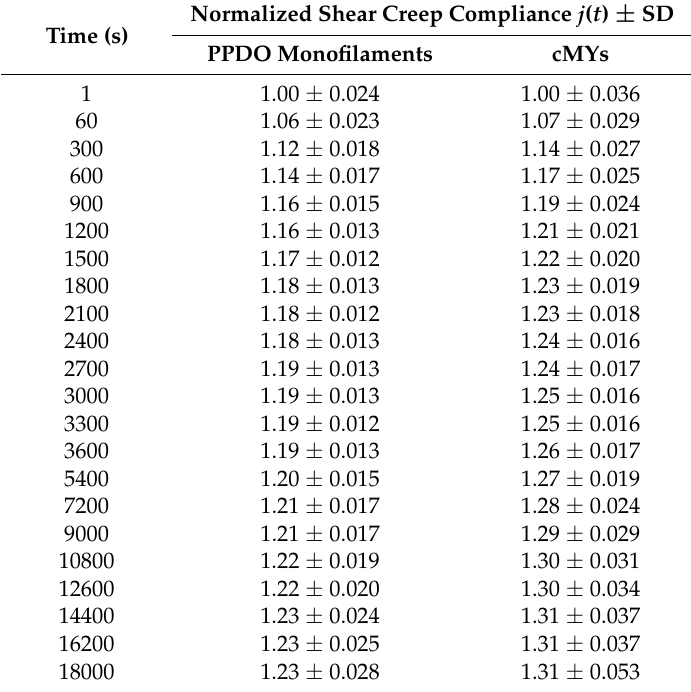
Table A1. Normalized shear creep compliance data converted from tensile creep